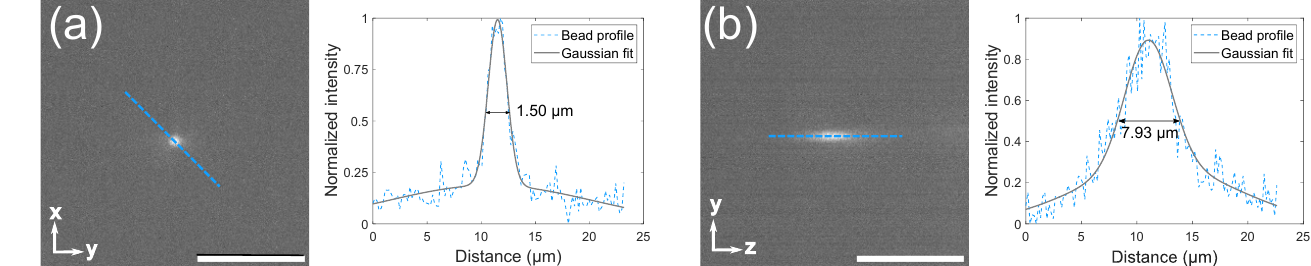
Figure 2. Resolution of the system. The graphs represent the Gaussian function (black) that fits the average microsphere profile together with the original data (blue), obtained from the diagonals pass- ing through the highest intensity pixel: ( a ) x-y cross-section of a 1 µm diameter microsphere; ( b ) x-z cross-section of a 1 µm diameter microsphere, both imaged with a 5 × Air Plan Apochromat objective. The resulting spatial resolution was 2.46 ± 0.60 µ m in the x and y axes and 9.28 ± 2.05 µ m in the z-direction using the 5 × objective and 1 µ m microspheres. Using the 20 × objective to image 0.5 µ m microspheres gave a resolution of 1.50 ± 0.43 µ m in the x and y axes and of 7.93 ± 1.41 µ m in the